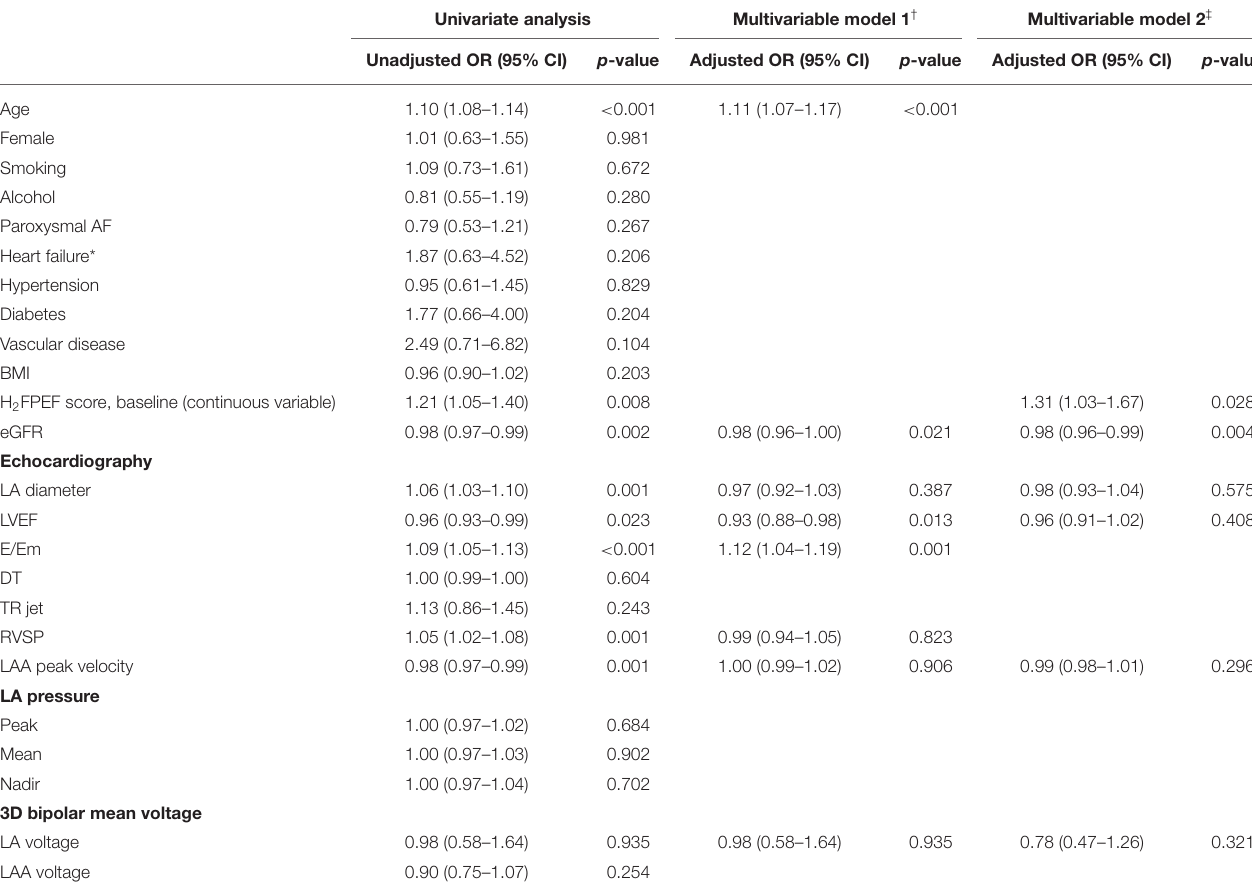
TABLE 3 | Univariate and multivariate logistic regression analysis for the predictors of prior ISs in patients with non-gender-related CHA 2 DS 2 -VA score 0 ∼ 1